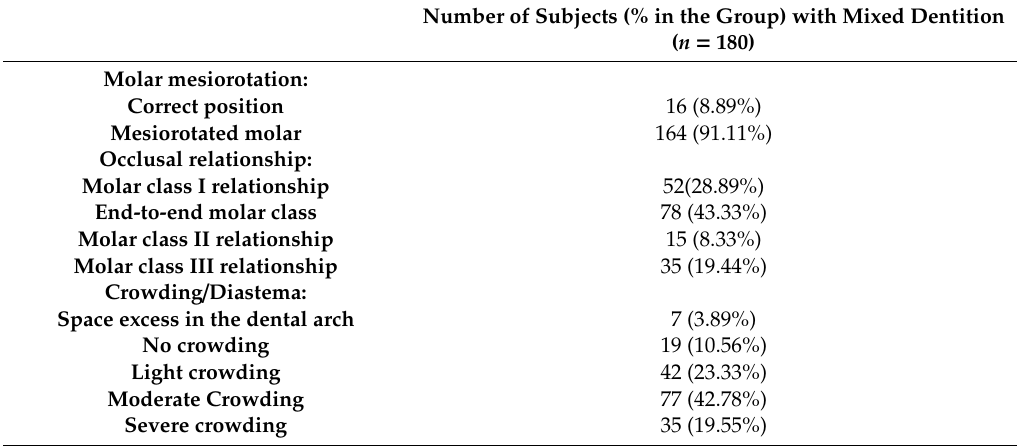
Table 1. Descriptive statistic (subject with mixed dentition) ( n = 180).